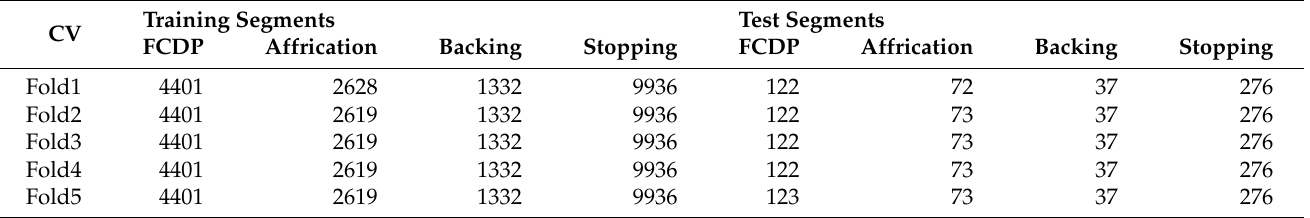
Table 3. The amount of data on single-Chinese-phrase dataset. Training segment contains aug- mented